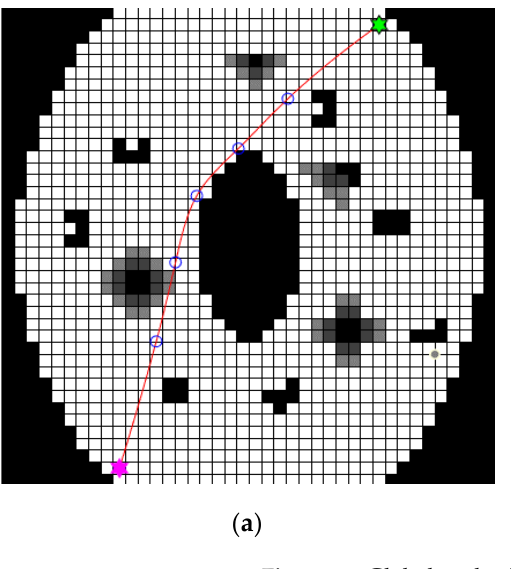
Figure 8. Global path planning results Improved Genetic Algorithm path planning: ( a ) Simple environment; ( b ) Complex environment.